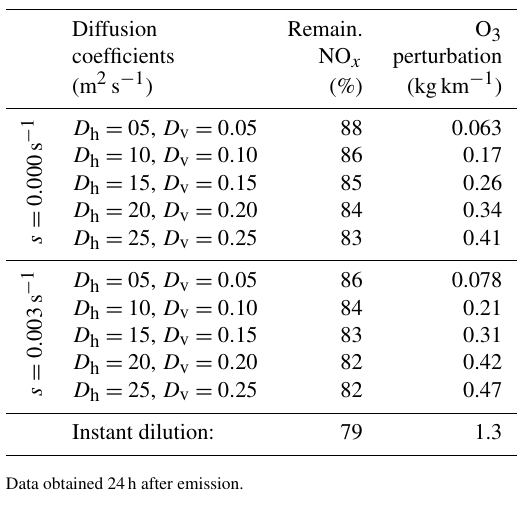
Table 4. Influence of diffusion parameters and wind shear on in- plume chemistry.